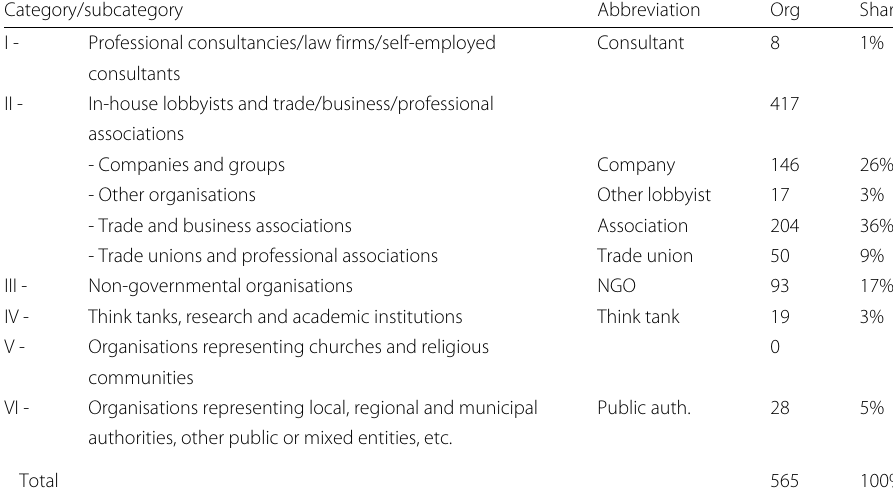
Table 1 Transparency Register categories and subcategories, and the distribution of the 565 lobby organizations (Org) analyzed in this